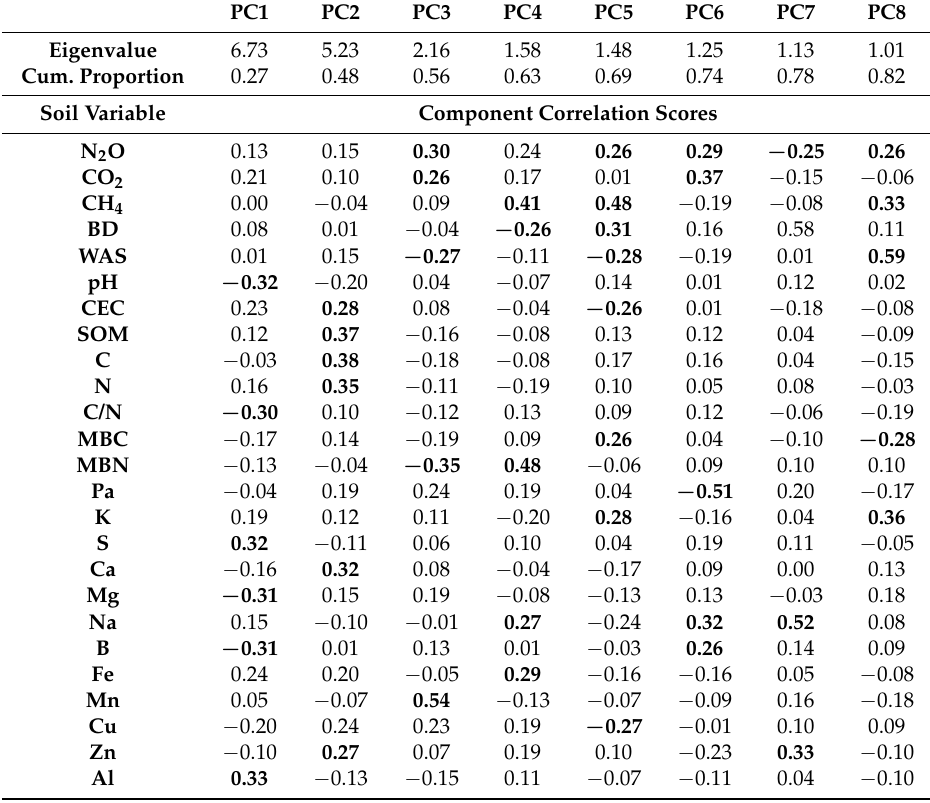
Table 4. Principal component analysis based on 52 observations modeling the yield index with 25 variables, with eigenvalues and the cumulative proportion of the dataset variability explained by the eight principal components (PC) extracted with eigenvalues >1. Component correlation scores (eigenvalues) with loadings greater than |0.25| are in